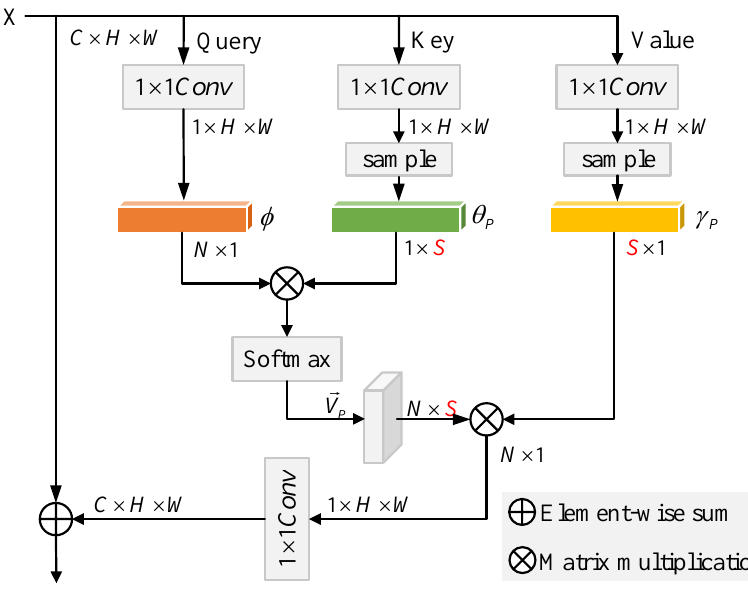
Figure 5. The asymmetric non-local residual block